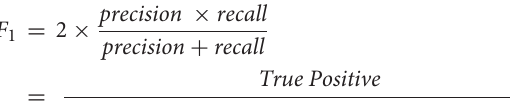
Supplementary Figure 2 ): serogroup prediction followed by PFGE pattern prediction. Consequently, a single serogroup prediction model and several serogroup-specific PFGE prediction models were created. For each model, the unimportant features were removed using feature selection to (a) reduce the time and complexity for model training, and (b) avoid overfitting of the